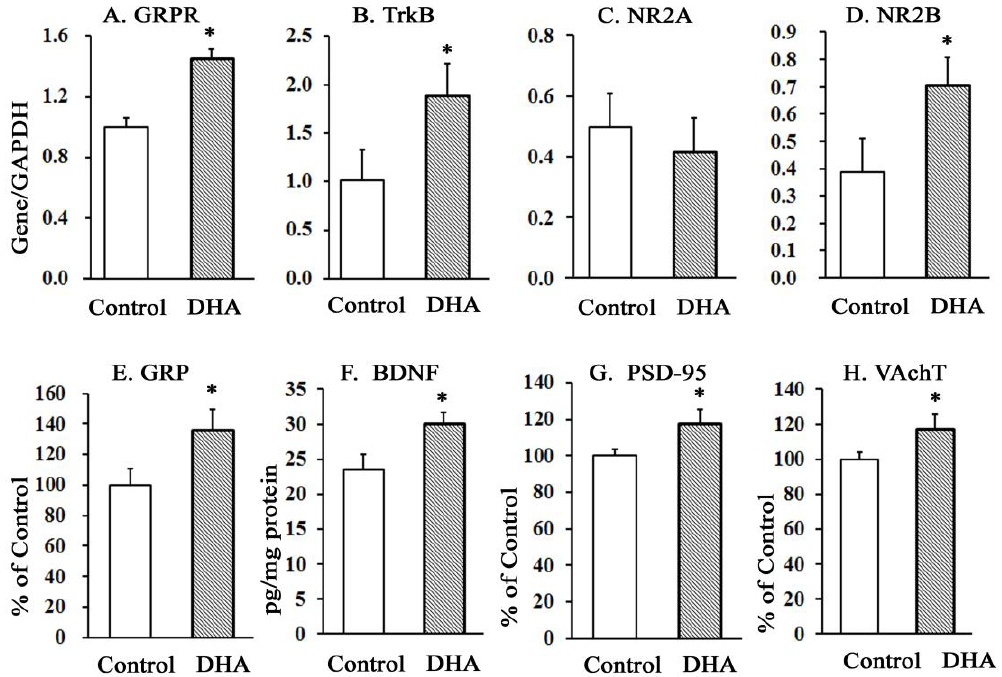
Figure 2. Effect of chronic oral administration of DHA on the mRNA levels ( A )–( D ) of hippocampus GRPR, TrkB, NR2A, and NR2B, and on the protein levels ( E )–( H ) of GRP, BDNF, PSD-95, and VAchT. The values are mean ± SEM ( n = 10), each with duplicate determinations; * p < 0.05 versus control group, student’s t- test.